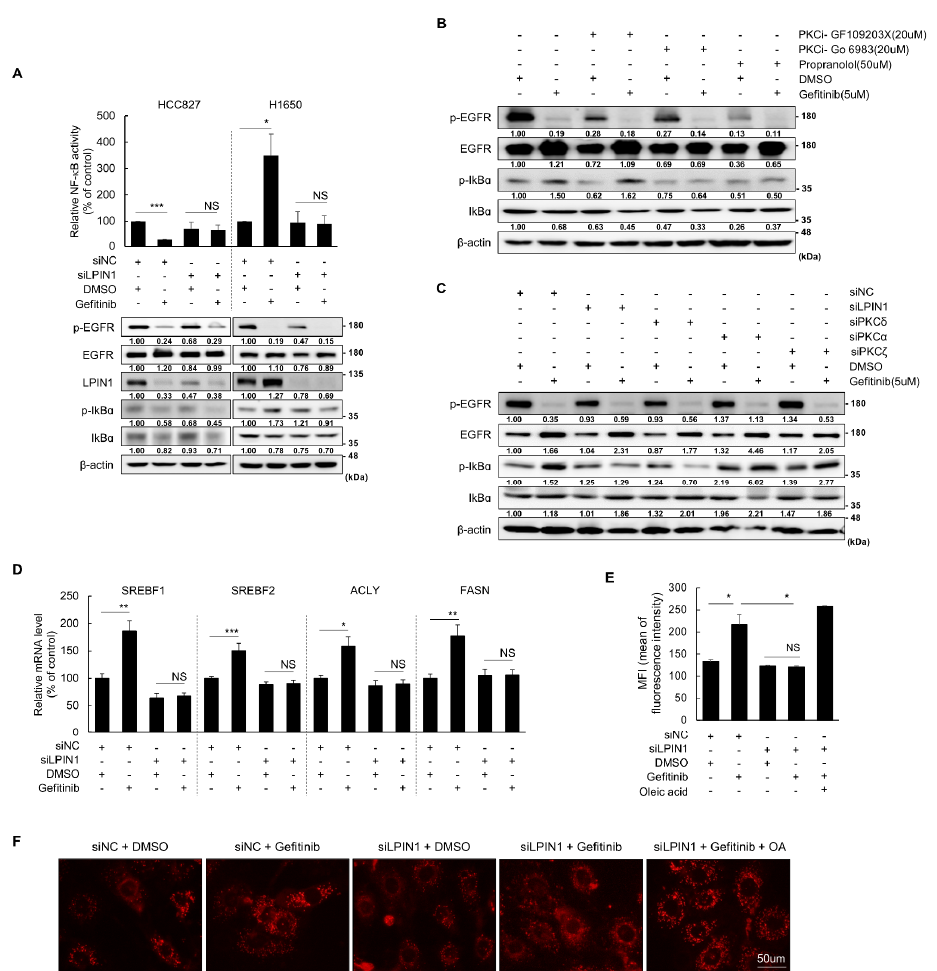
Figure 3. NF- κ B signaling and LD formation are activated in an LPIN1-dependent manner in gefitinib-resistant H1650 cells. ( A ) H1650/siLPIN1, H1650/siNC, HCC827/siLPIN1, or HCC827/siNC cells transfected with NF- κ B luciferase reporter plasmid were treated with gefitinib (5 μ M) or DMSO for 24 h and then harvested to determine NF- κ B activity (upper panel) and p-I κ B α expression levels (lower panel). ( B ) H1650 cells were pretreated with PKC α , β , or γ inhibitors (GF109203X (20 μ M, S7208) or Go 6983 (20 μ M, S2911)) or LPIN inhibitor (50 μ M propranolol) for 2 h, treated with 5 μ M gefitinib, and subjected to western blot analysis to determine p-I κ B α expression levels. ( C ) H1650 cells were transfected with siRNAs for LPIN1, PKC α , PKC δ and PKC ζ individually, treated with gefitinib (5 μ M) or DMSO for 24 h, and subjected to western blot analysis to determine p-I κ B α expression levels. ( D ) H1650 cells were transfected with siRNAs for LPIN1 and then treated with gefitinib (5 μ M) or DMSO for 24 h. qRT-PCR was performed to determine the mRNA expression of the indicated genes. ( E , F ) H1650 cells were transfected with siRNAs for LPIN1 and treated with gefitinib (5 μ M) or DMSO for 24 h. The cells were subjected to € flow cytometry to determine lipid droplet production or ( F ) Nile red staining to visualize lipid droplets under a fluorescence microscope. Oleic acid (10 μ M) was used as the positive control of lipid droplet production. Values are the mean ± SD of three independent experiments. Statistical significance was determined by ( A , D ) Student’s t -test € ( E ) two-way ANOVA (*, p < 0.05; **, p < 0.01; ***, p < 0.001; and NS, not significant).